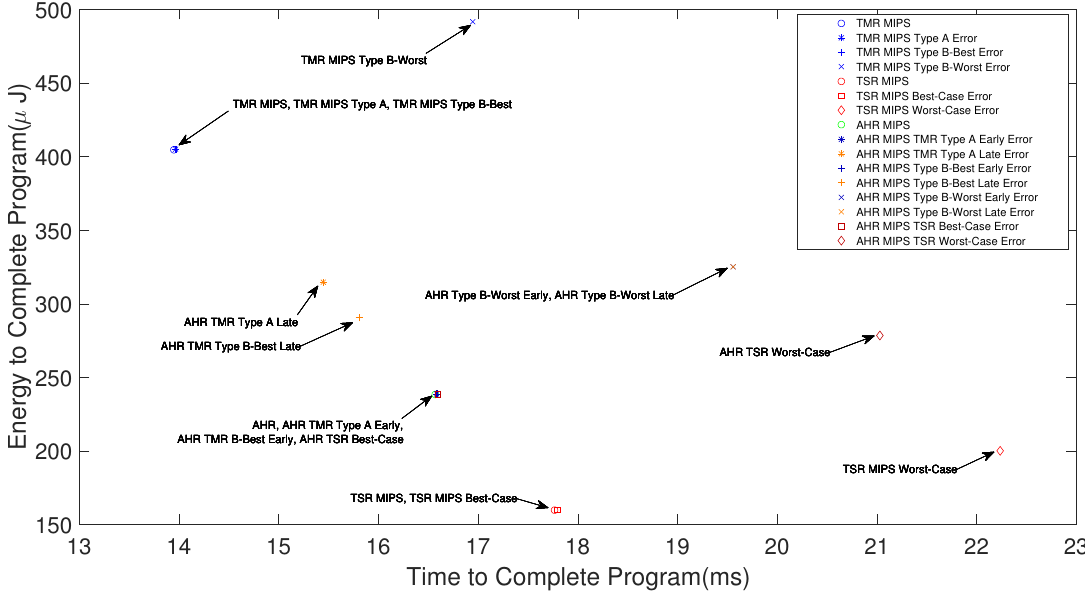
Figure 6. Averaged results of software simulation of all errors: energy vs. time to